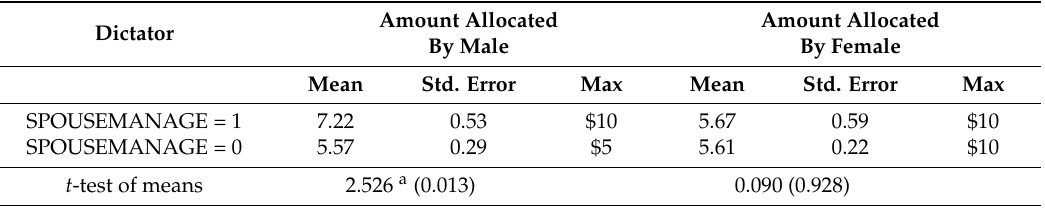
Table 6. Allocation of $10 based on SPOUSEMANAGE by